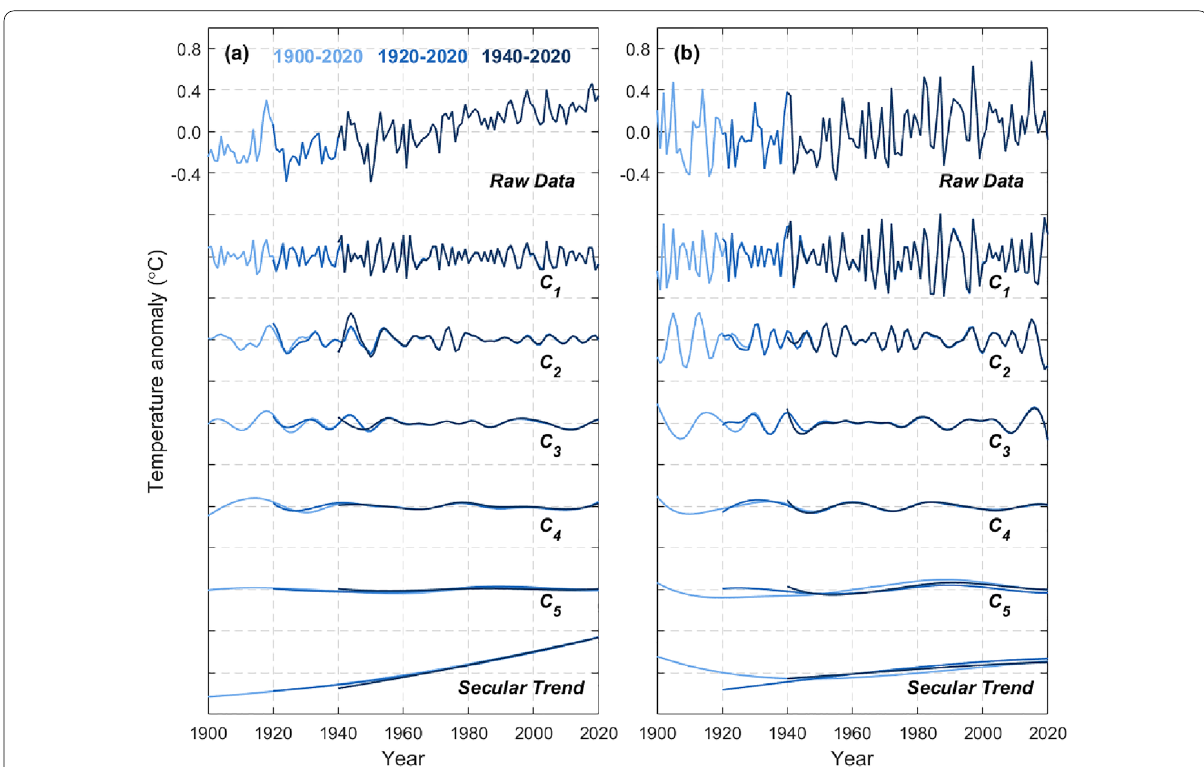
Fig. 2 The temporal locality of EEMD decomposition of the annual SSTA at a (42°S—46°S, 58°W—54°W) averaged in the South Atlantic; b (2°S— 2°N, 122°W—118°W) averaged in the equatorial Pacific. From top to bottom, the curves represent the raw data, EEMD components ( c j ), and secular trend. The curves are colored from light to dark in each panel, representing 1900–2020, 1920–2020, and 1940–2020,